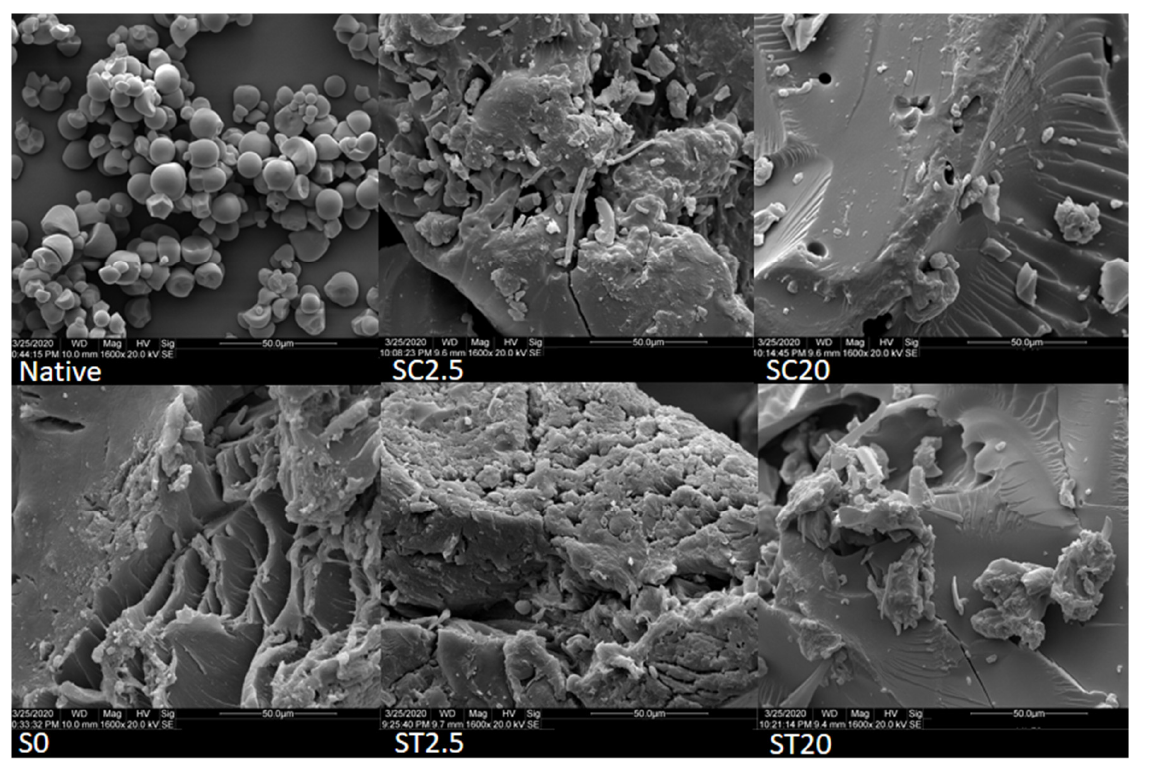
Figure 3. SEM images of native starch, the control sample (extruded without reagent—S0), and starch hydrogels obtained by reactive extrusion through reaction with CA (SC2.5 and SC20) and TA (ST2.5 and ST20).